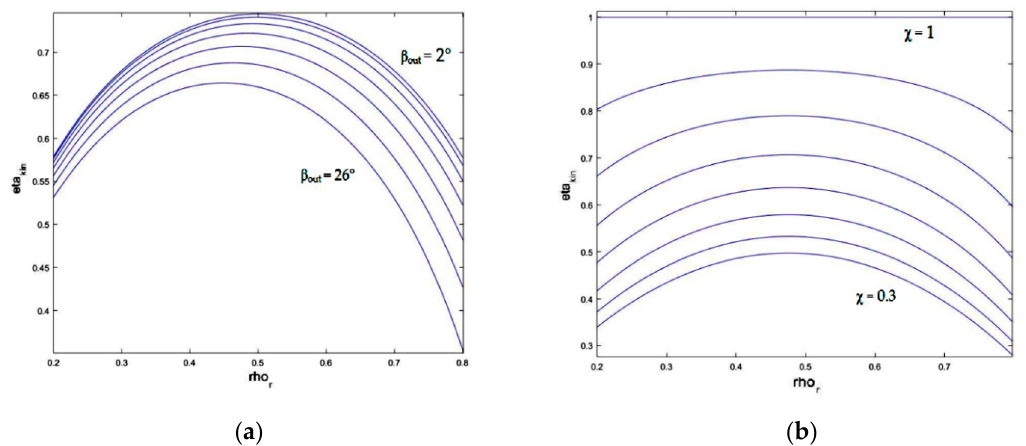
Figure 8. Kinematic efficiency: ( a ) Variation of the kinematic efficiency with ρ r for different β out and fixed χ ; ( b ) Variation of the kinematic efficiency with ρ r for different χ and fixed β out .